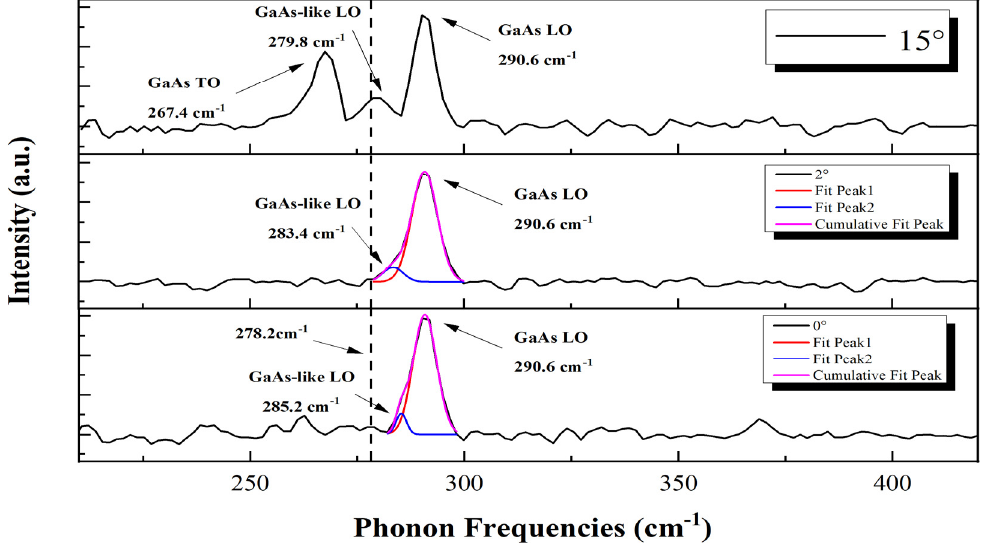
Figure 3. Raman spectra of InGaAs/GaAsP QWs grown on a GaAs (001) substrate with mis- orientations of 0°, 2°, and 15° using a 488 nm laser. tions of 0 ◦ , 2 ◦ , and 15 ◦ using a 488 nm